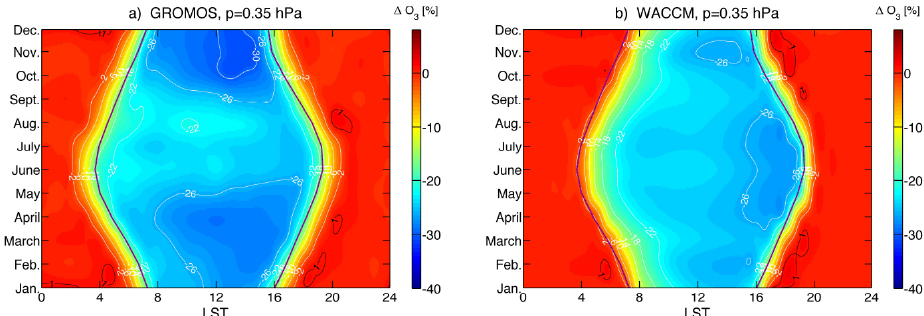
Figure 8. Same as Fig. 7 but for the pressure level 0.35hPa in the